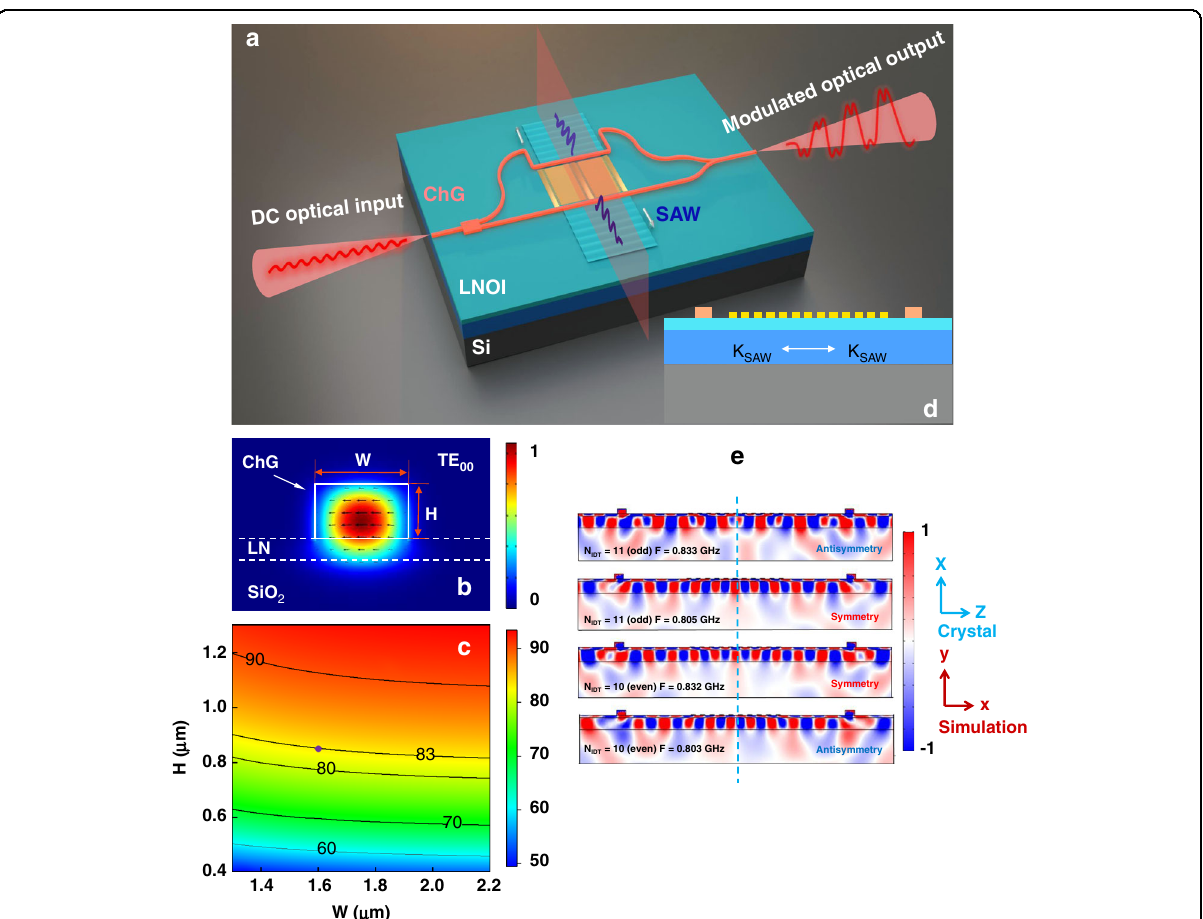
Fig. 1 Design of a built-in push-pull AO modulator based on a nonsuspended TFLN-ChG hybrid waveguide platform. a Schematic diagram of the proposed device. The MZI waveguide is etched on the top of the Ge 25 Sb 10 S 65 fi lm (orange), which is deposited on the LNOI wafer (light blue). The IDT made of Au electrodes (yellow) is evaporated in the region between the two arms. In principle, the direct current (DC) optical input is modulated into a distorted sinusoidal time-domain signal via a varied SAW. b Electric fi eld of the fundamental TE mode. W and H are the width and height of the ChG rectangular waveguide, respectively. c Relation between the energy con fi nement factor Γ in the ChG waveguide and waveguide geometry. d Cross-sectional view of the proposed device. The colors of the waveguide materials are the same as in ( a ). e Numerical simulation results of the dominant S xx strain components of the SAW modes in the heterogeneous-integration waveguide platform with the double arm modulation con fi guration. The upper two pictures are the antisymmetric and symmetric acoustic modes corresponding to 5.5 pairs of IDT fi ngers (N IDT = 11), and the lower two are the symmetric and antisymmetric acoustic modes corresponding to fi ve pairs of IDT fi ngers (N IDT = 10). The color scale bars are